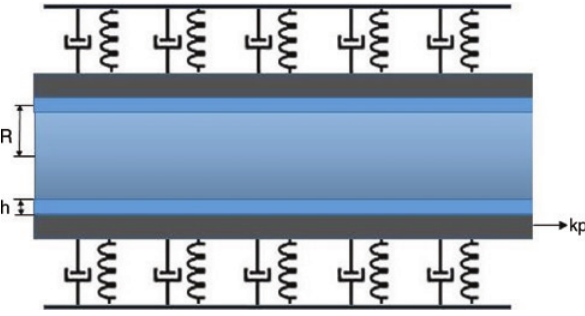
Figure 1: Geometry of FG cylindrical microshell surrounded by a viscoelastic